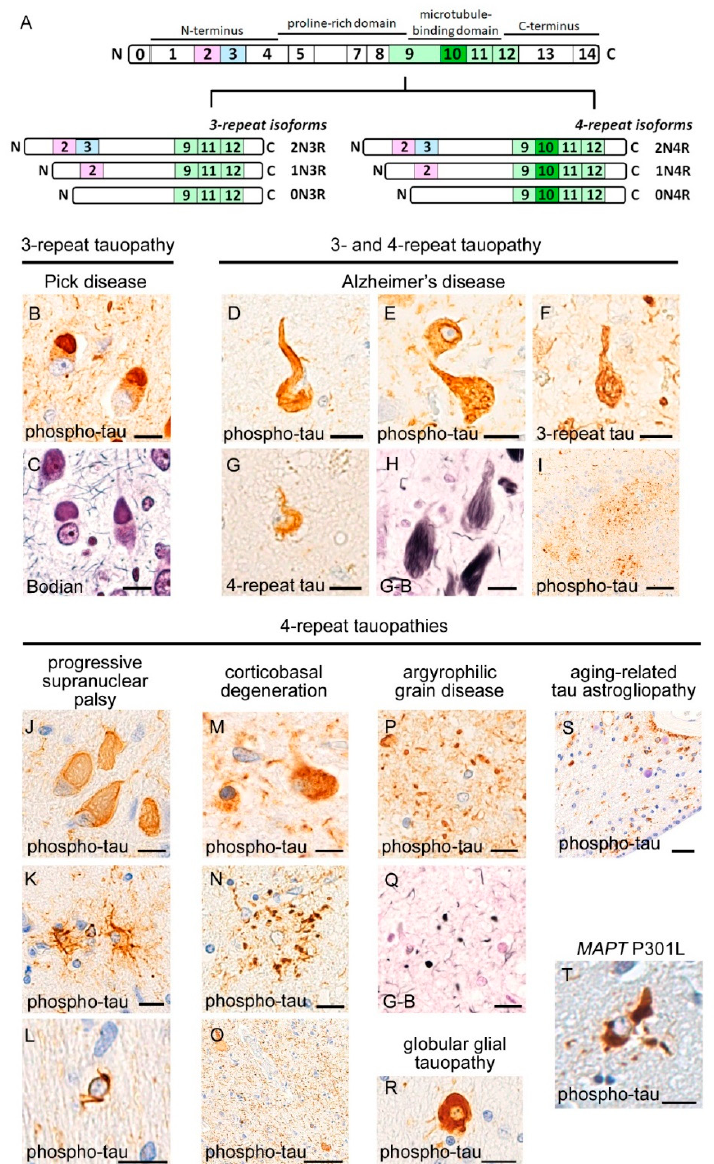
Figure 2. Neuropathological findings of tauopathies. Microtubule associated protein tau (MAPT) gene expressed in human brain is shown ( A ). Alternative splicing of exons 2, 3, and 10 generates six isoforms, which are subclassified into 3 repeat and 4 repeat isoforms by the absence or presence of